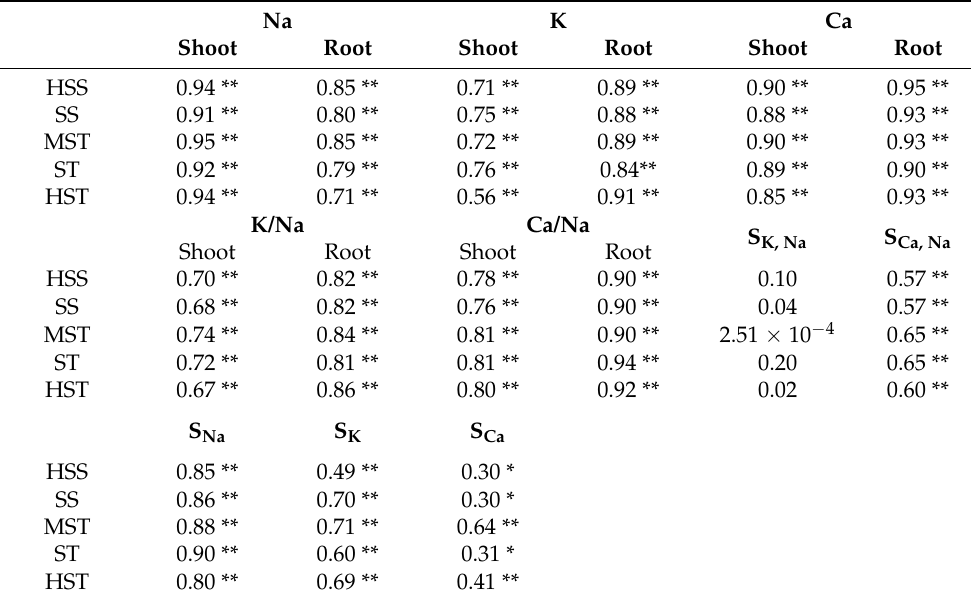
Table 1. Correlation coefficients between the shoot and root ion contents, absorption, and transport, and the NaCl concentrations in the B. napus inbred lines of five salt-tolerance categories. Na K Ca Shoot Root Shoot Root Shoot Root HSS 0.94 ** 0.85 ** 0.71